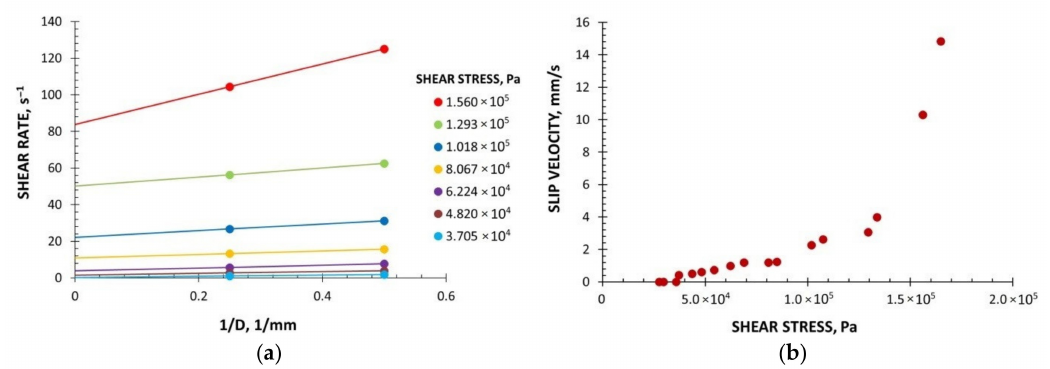
Figure 3. Material characteristics (PP copo inj 4, Beologic), Mooney analysis: ( a ) Shear rate vs. 1/D, ( b ) slip velocity vs. shear stress, D—capillary diameter.